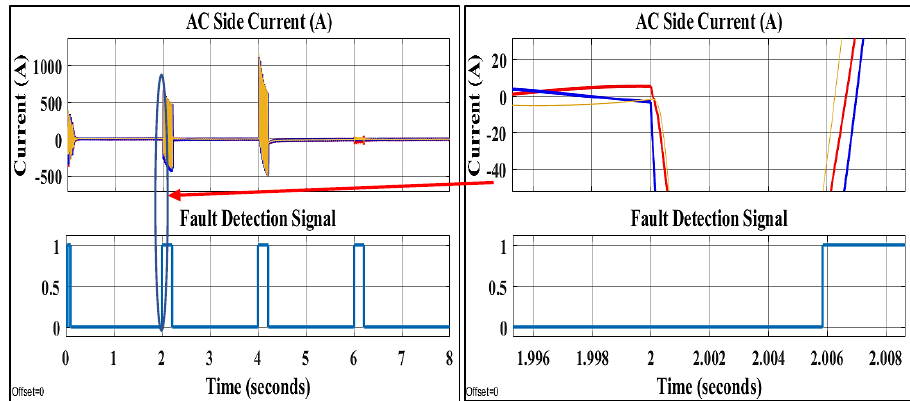
Figure 21. AC bus frequency under faults occur .